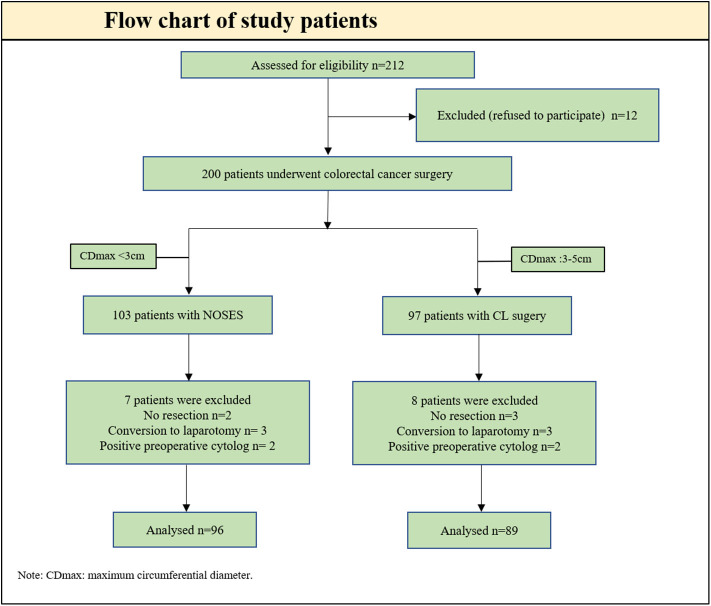
Flow chart of study patients. CD max, maximum circumferential diameter.